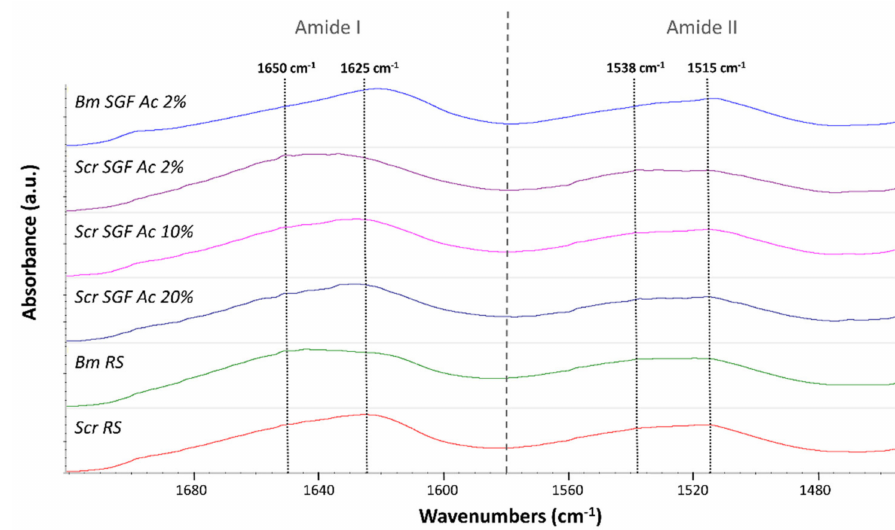
Figure 2. Infrared spectra of silkworm gut fibres produced from silk glands of S.c. ricini (Scr SGF) under different experimental conditions and from B. mori (Bm SGF), as well as those correspondent to raw silk fibroins produced by both species of silkworms (named as Scr RS and Bm RS, respectively). The figure focuses on amide peaks I and II, highlighting the wavenumbers whose absorbances have been used to calculate the crystallinity indices, 1625 and 1650 cm − 1 (for the amide I peak) and 1515 and 1538 cm − 1 (for the amide II peak).